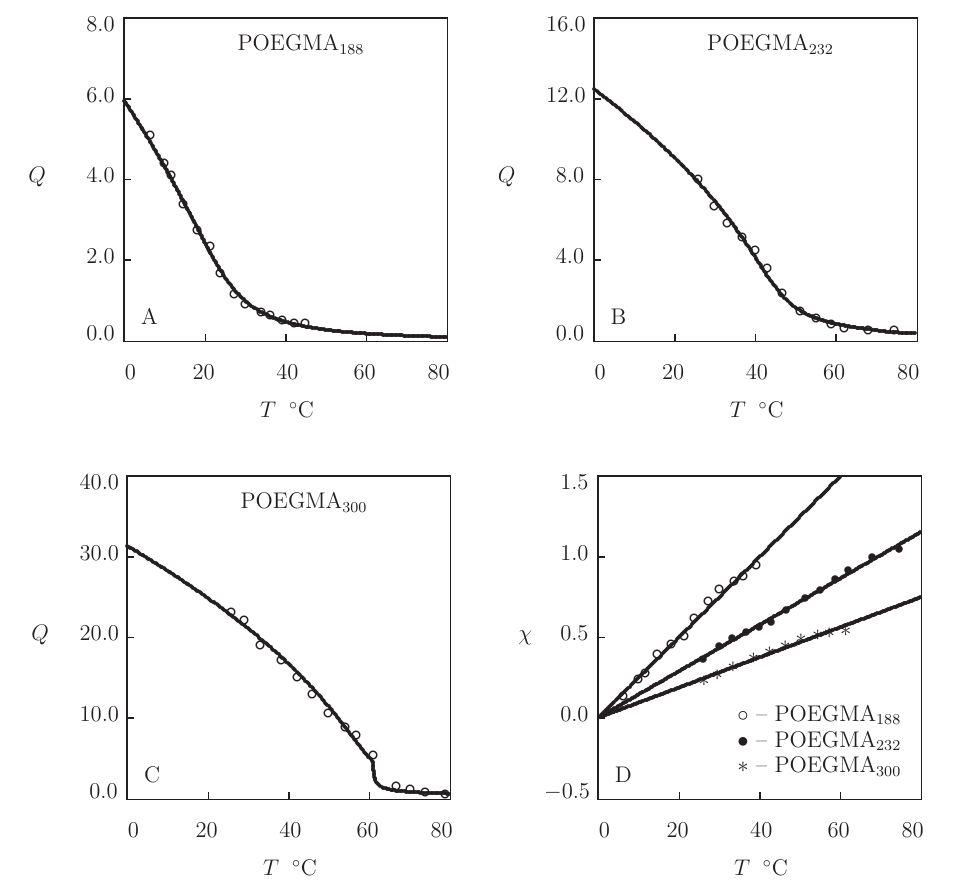
Figure 12. ( A – C ) Degree of swelling Q versus temperature T . Circles: experimental data [28] on POEGMA 188 , POEGMA 232 and POEGMA 300 microgels. Solid lines: results of simulation. ( D ) Pa- rameter χ versus temperature T . Symbols: treatment of experimental data. Solid lines: results of